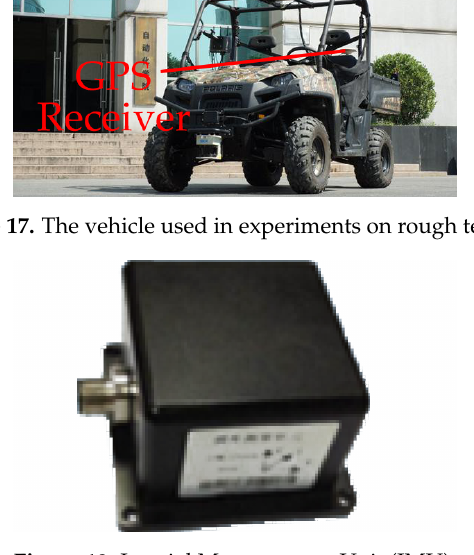
Figure 18. Inertial Measurement Unit (IMU). Table 6. The specifications of the